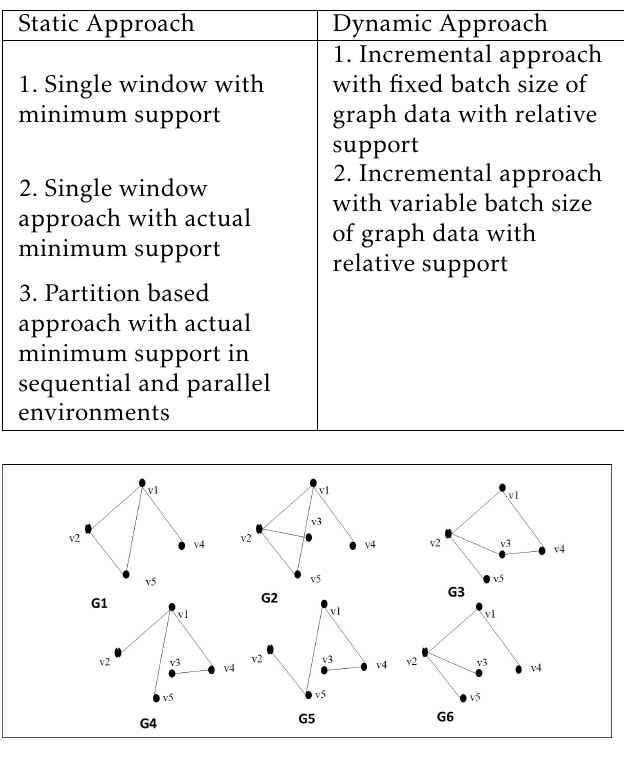
Figure 1. Sequence of graph streams G1, G2, G3, G4, G5,